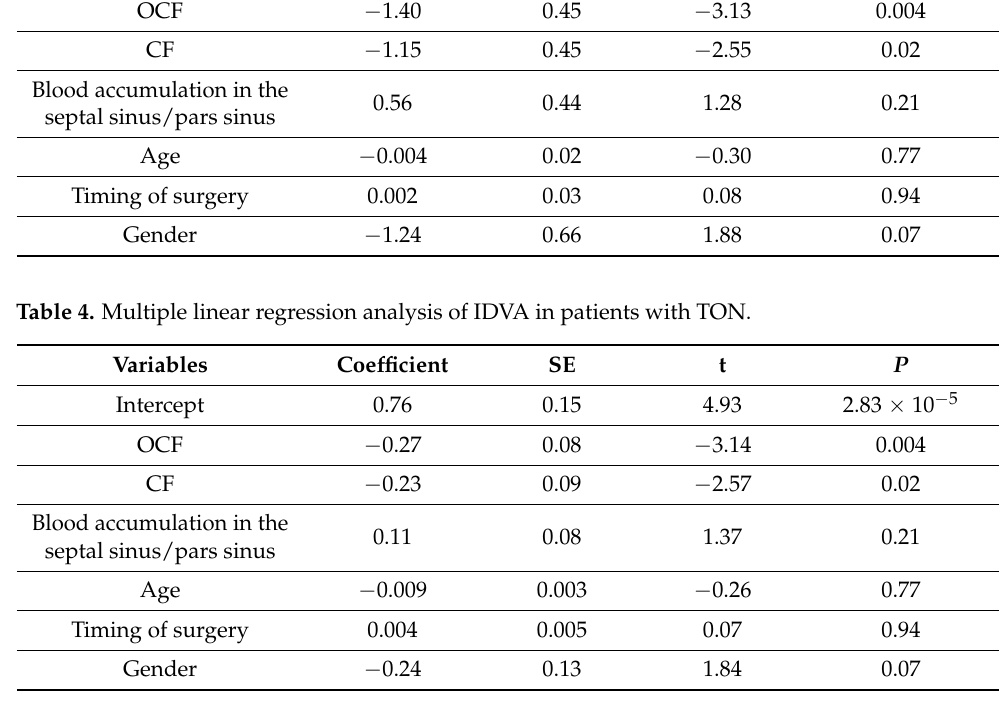
Table 3. Multiple linear regression analysis of postoperative visual acuity in patients with TON.